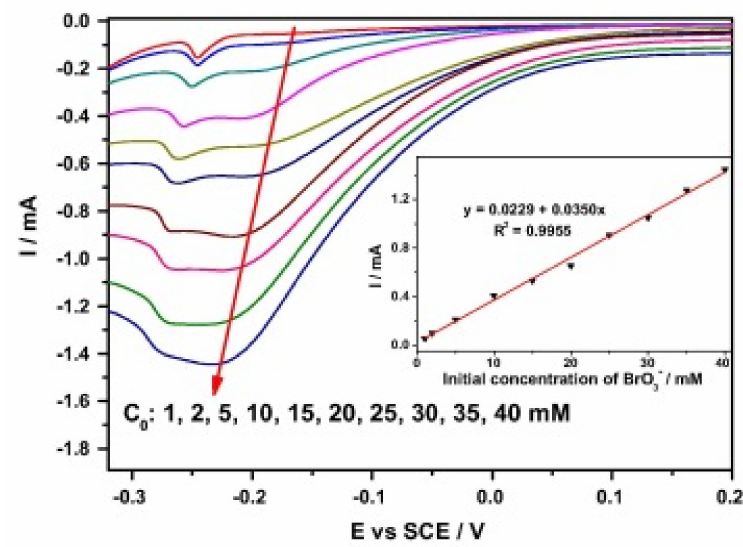
Figure 5. A series of cyclic voltammograms of Pd-NPs/PANI/SBA-15 in 0.5 mol L − 1 H 2 SO 4 with different BrO 3 concentrations of 1, 2, 5, 10, 15, 20, 25, 30, 35 and 40 mmol L − 1 at a scan rate of 20 mV s 1 . The inset in the picture shows the plotting of the corresponding reduction peak current vs. the BrO 3 concentration (adapted from [60] with